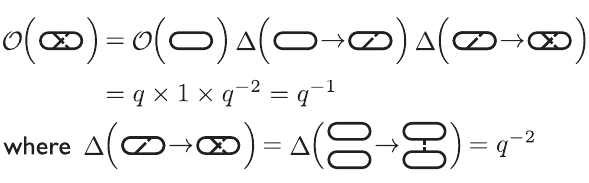
FIG. 12. An example of order determination of a diagram using the method of contraction addition. Arrows giving an orientation to loops are omitted for clarity.